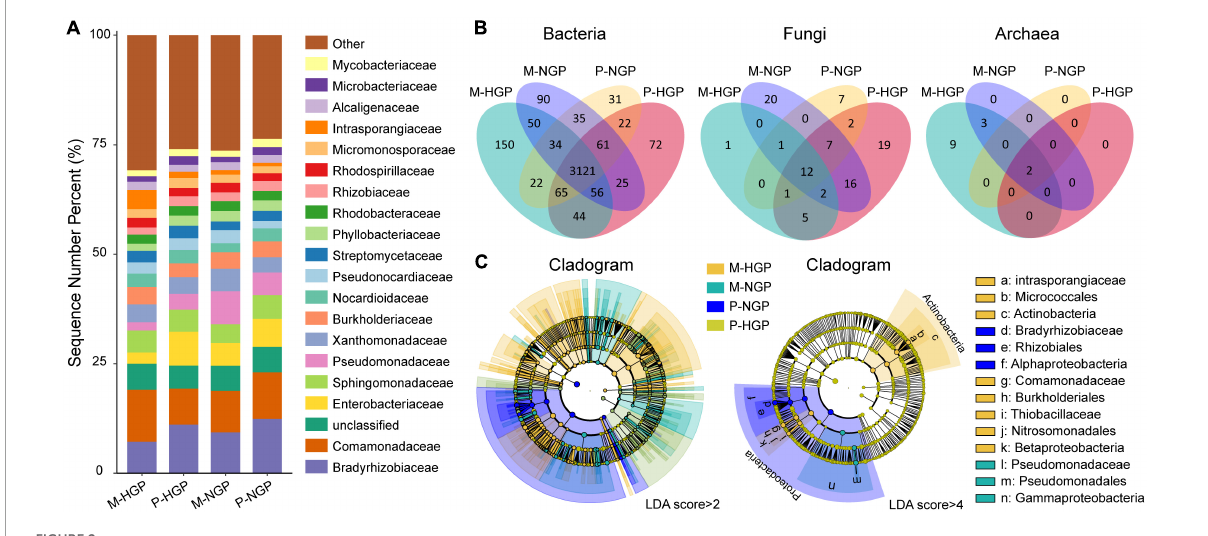
FIGURE2 Response of microbial composition to GE. (A) Relative abundances of soil microbes at the family level at depths of 0–10 cm. Other classification levels are shown in Supplementary Figure 1 . (B) Venn diagrams of shared and unique species of bacteria, fungi, and archaea. (C) Cladograms of microbial biomarkers at the family level identified using the LEfSe method at LDA scores of (log 10) > 2 and (log 10) > 4.